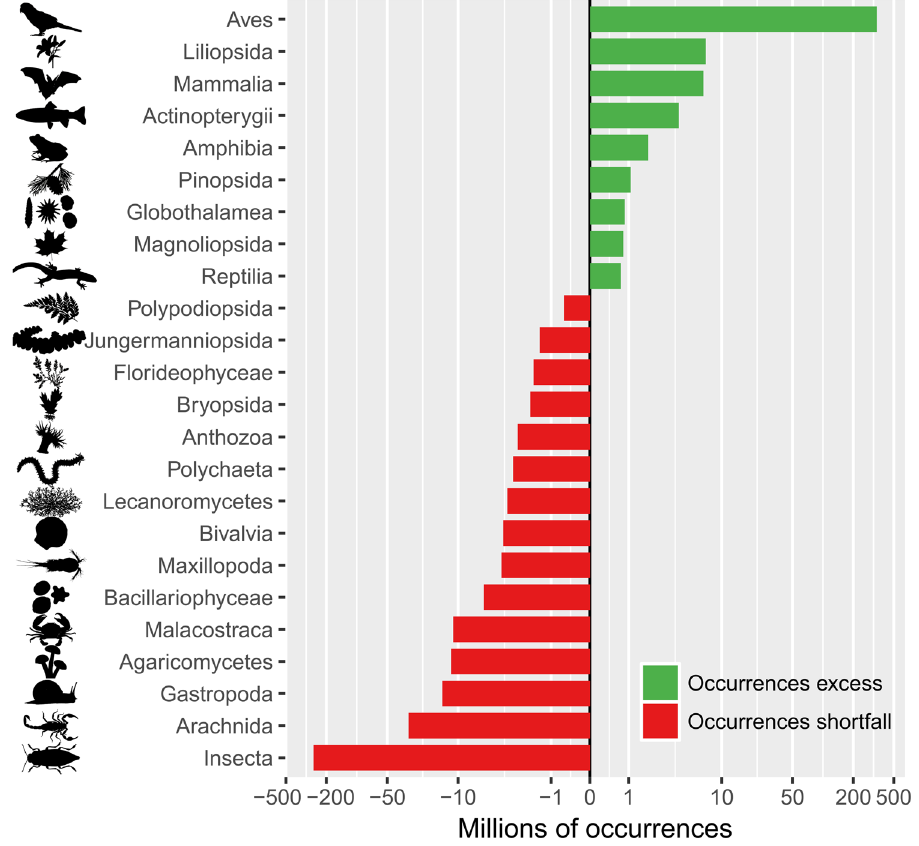
Figure 1. Taxonomic bias in biodiversity occurrence data. The vertical line at x = 0 depicts the ‘ideal’ number of occurrences per class, where each class is sampled proportionally to its number of known species. Green and red bars show the classes that are over- and under-represented in the GBIF mediated database compared to this ‘ideal’ sampling, respectively. Insects lack > 200 millions occurrences and birds have an excess of > 200 millions occurrences compared to an unbiased taxonomic sampling. Because birds and insects are greatly over- and under-represented, respectively, an inverse hyperbolic sine transformation was used for the